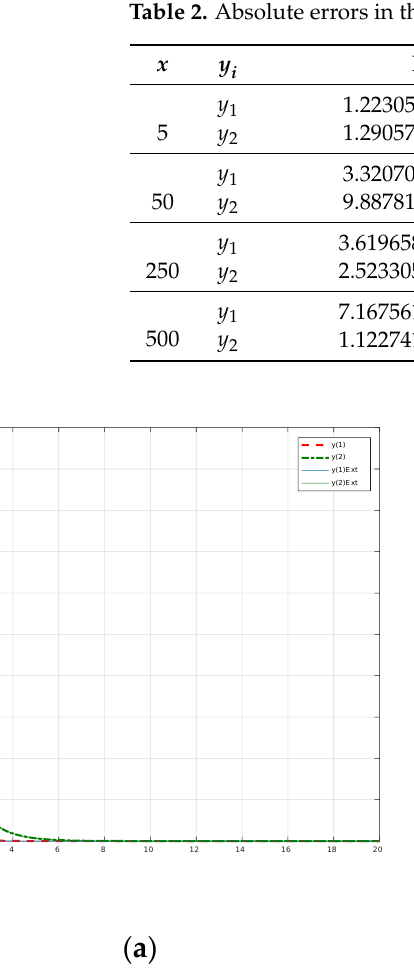
Table 2. Absolute errors in the numerical integration of example 1.